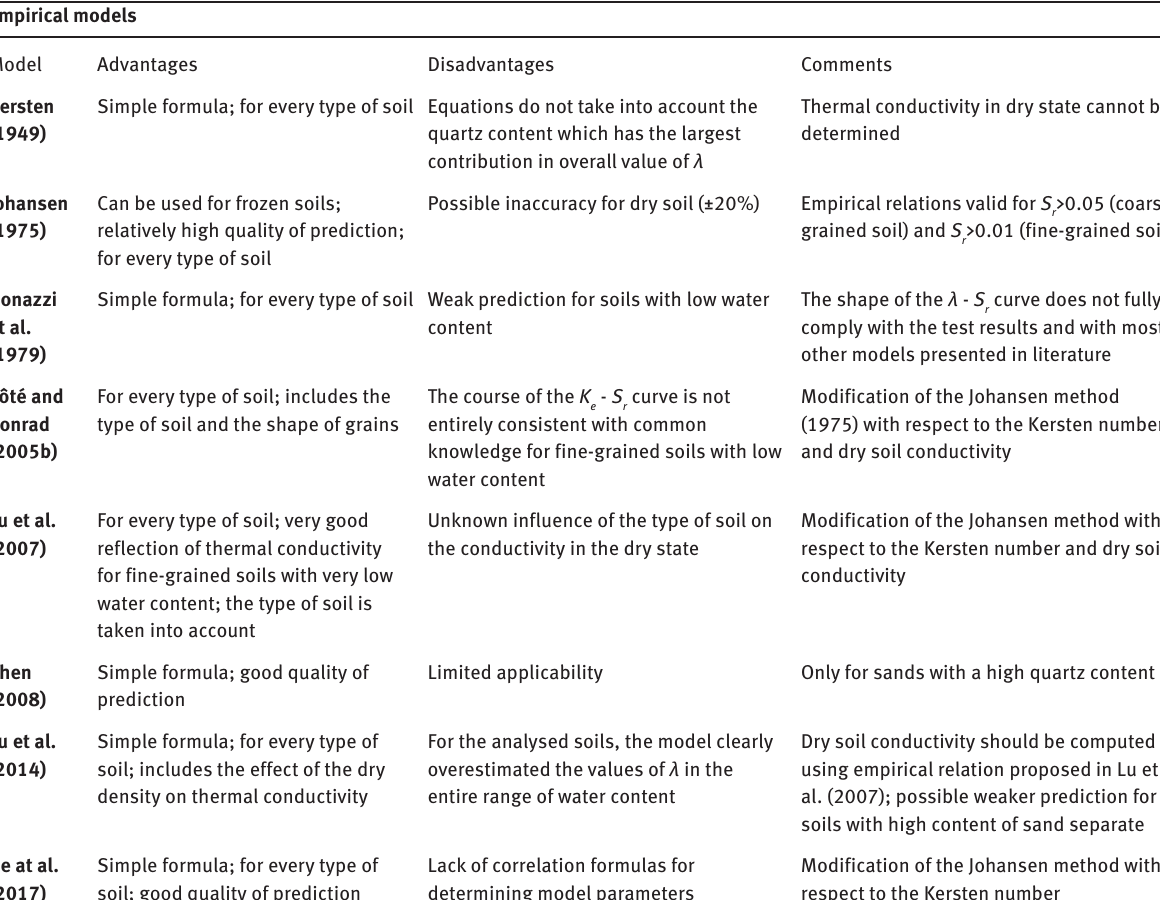
Figure 7: Prediction of thermal conductivity for fine-grained soil at different saturation states (expressed as saturation degree S measurement results (from Lu et al., 2007). Table 2: Advantages, disadvantages and comments on considered empirical models (Różański,